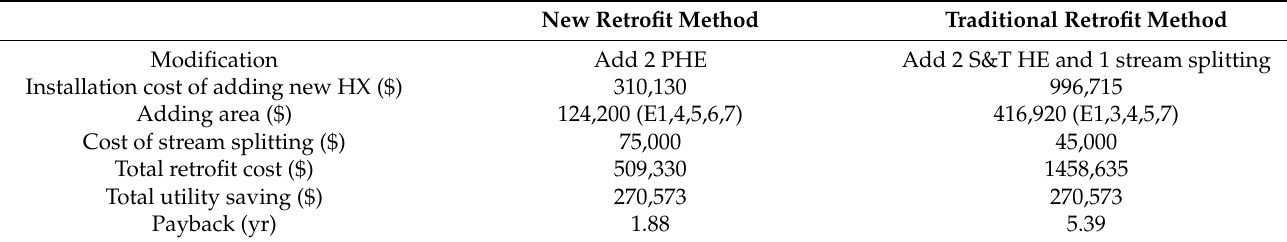
Table 3. The comparison of two different